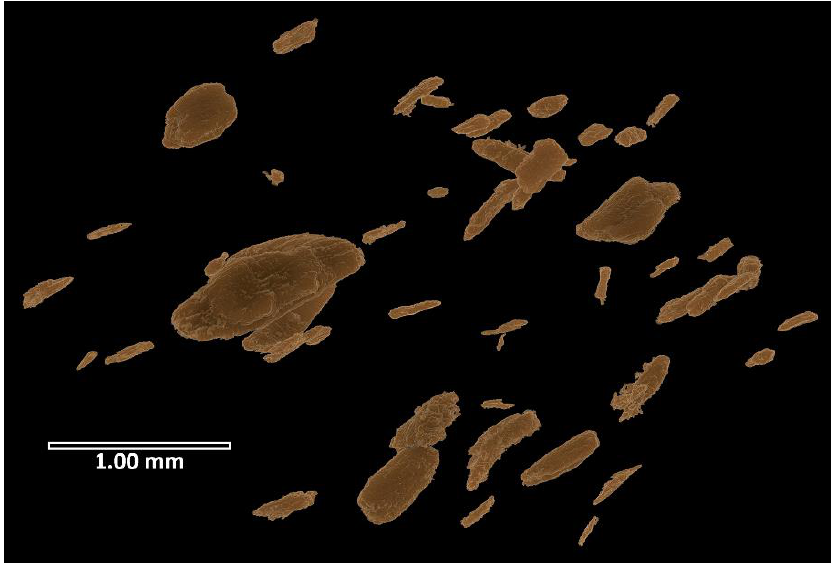
Figure 4. Images of each of the wood particles that were randomly selected from a volume within the labeled WPC sample.